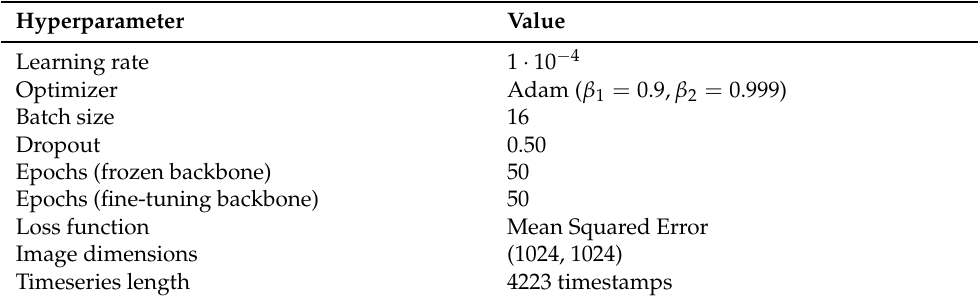
Table 2. Summary of the hyper-parameters used to train the multi-modal network. Hyper-parameters were tuned